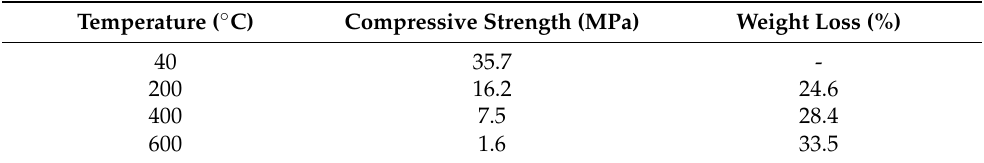
Table 6. Compressive strength and weight loss of the MW/MK 0.3 AAM (marble waste to metakaolin